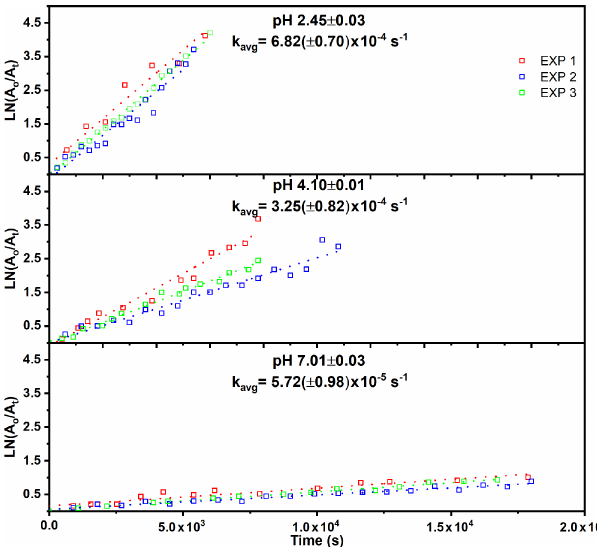
Figure 8. Hydrolysis rate constants for the bulk (gas- and particle- phase) organic nitrates at different pHs. Each pH was analyzed in triplicate, and the k avg is the average slope of each of the three